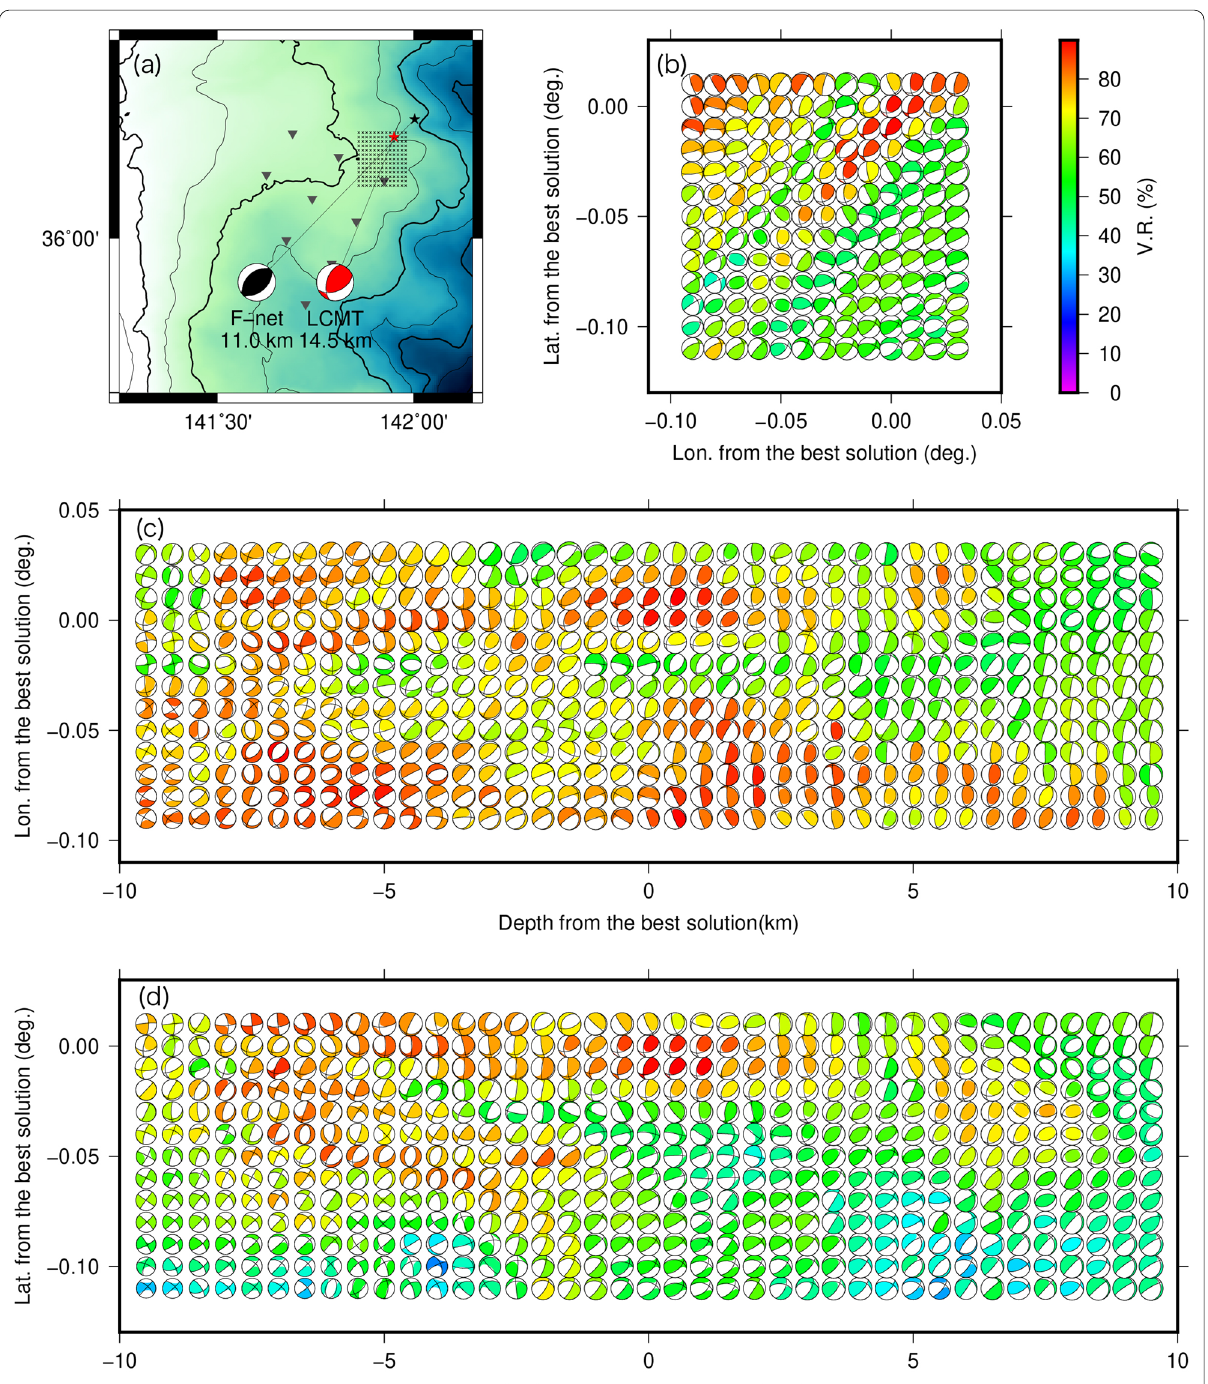
Fig. 10 Result of the CMT inversions for the earthquake that occurred at 9:06, March 16, 2011 (JST), using sparse OBS stations. Notations are the same as Fig.